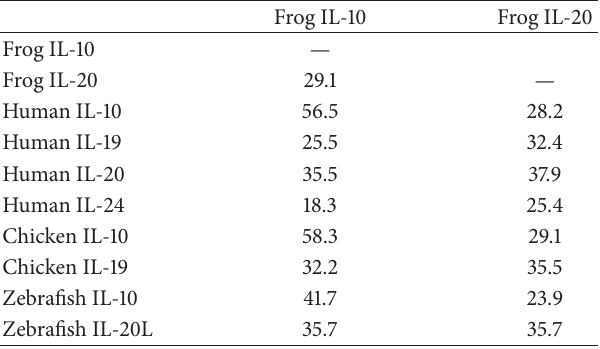
Table 2: Sequence identities among frog IL-10, frog IL-20, and IL-10 family members from other